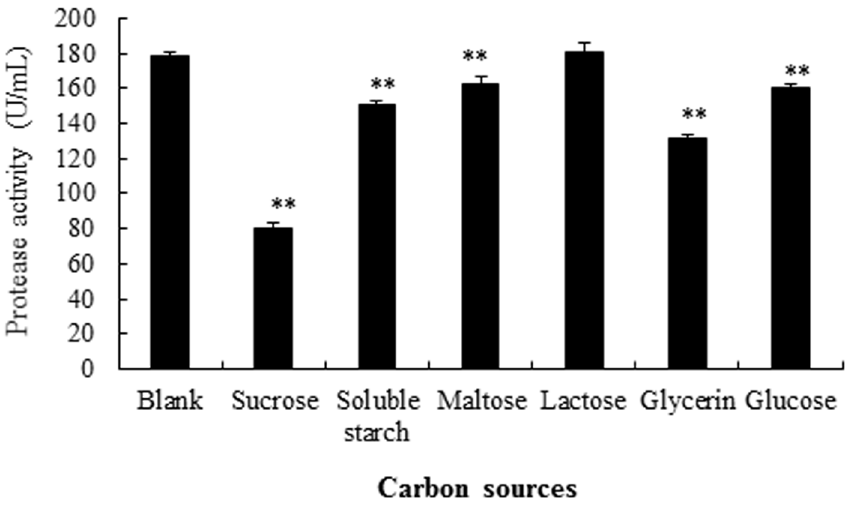
Fig 5. Effects of carbon sources in influencing the production of alkaline protease from strain SD8. LB medium without carbon added was selected as blank control. * P < 0.05 and ** P < 0.01 compared to blank control. All the data were given as means ± SEM (n = 3).